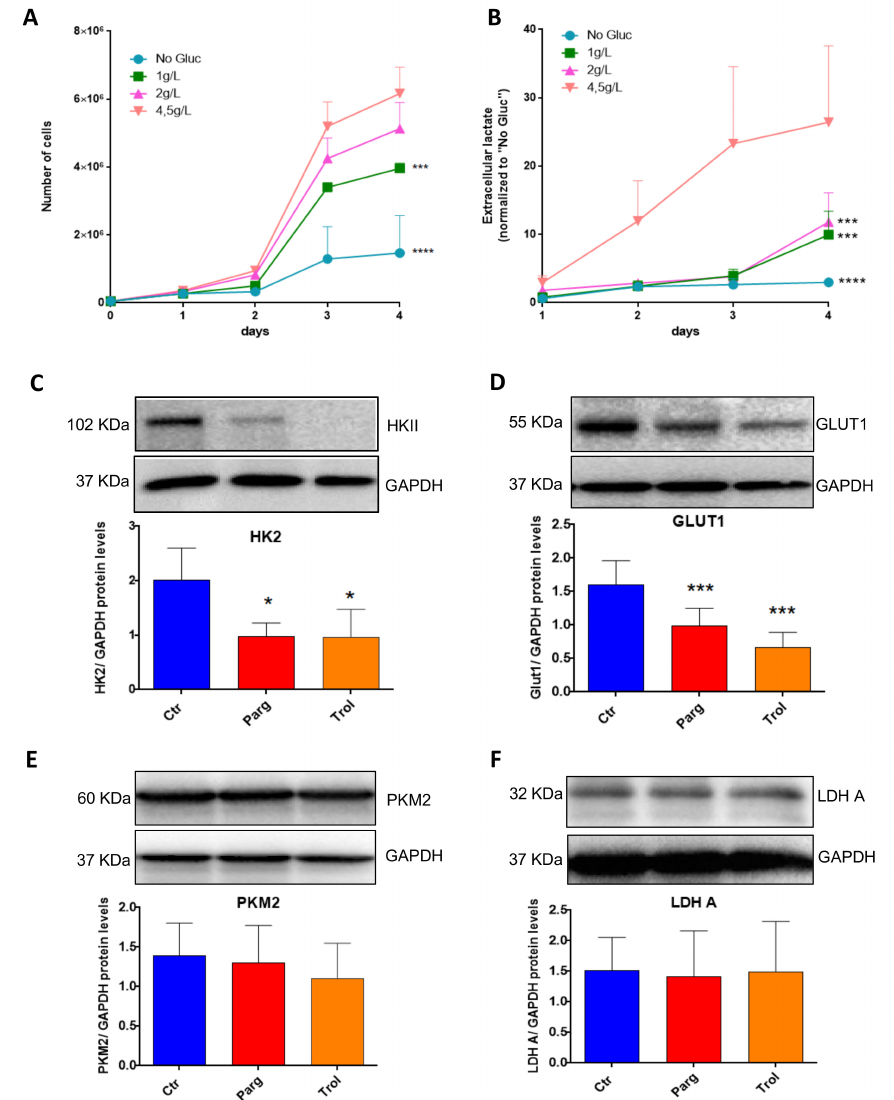
Figure 7. MAOs regulate protein levels of GLUT1 and HKII in AY27 cells. ( A ) Proliferation curves of AY27 cells cultured in the presence of different concentrations of glucose (0 g/L, 1 g/L, 2 g/L, 4.5 g/L). Cells were counted each day until 96 h (N = 3). ( B ) Lactate concentrations in the supernatants of AY27 cells cultured in the presence of different concentrations of glucose (0 g/L, 1 g/L, 2 g/L, 4.5 g/L) for 96 h (N = 3). ( C – F ) Western blot analysis of HK2, GLUT1, LDHA and PKM2 protein expression levels in AY27 cells after 96 h of treatment with pargyline or Trolox (N = 5). All the values are expressed as mean ± SEM. * p < 0.05, *** p < 0.001, **** p < 0.0001 compared with No Gluc ( A , B ) or Ctr conditions ( C – F